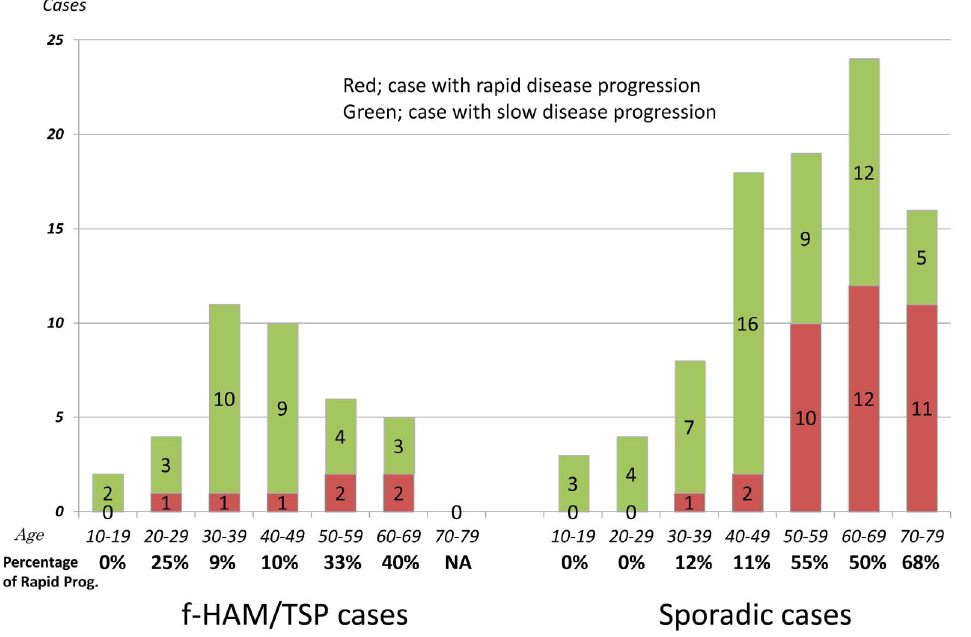
Figure 2. Age-specific proportions of rapid disease progression. The proportion of cases with rapid disease progression tended to increase with the older age of onset.